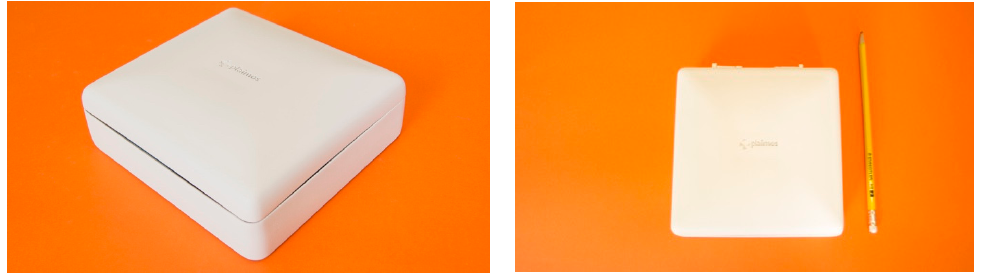
Figure 8. PlaIMoS fixed measurement station closed.